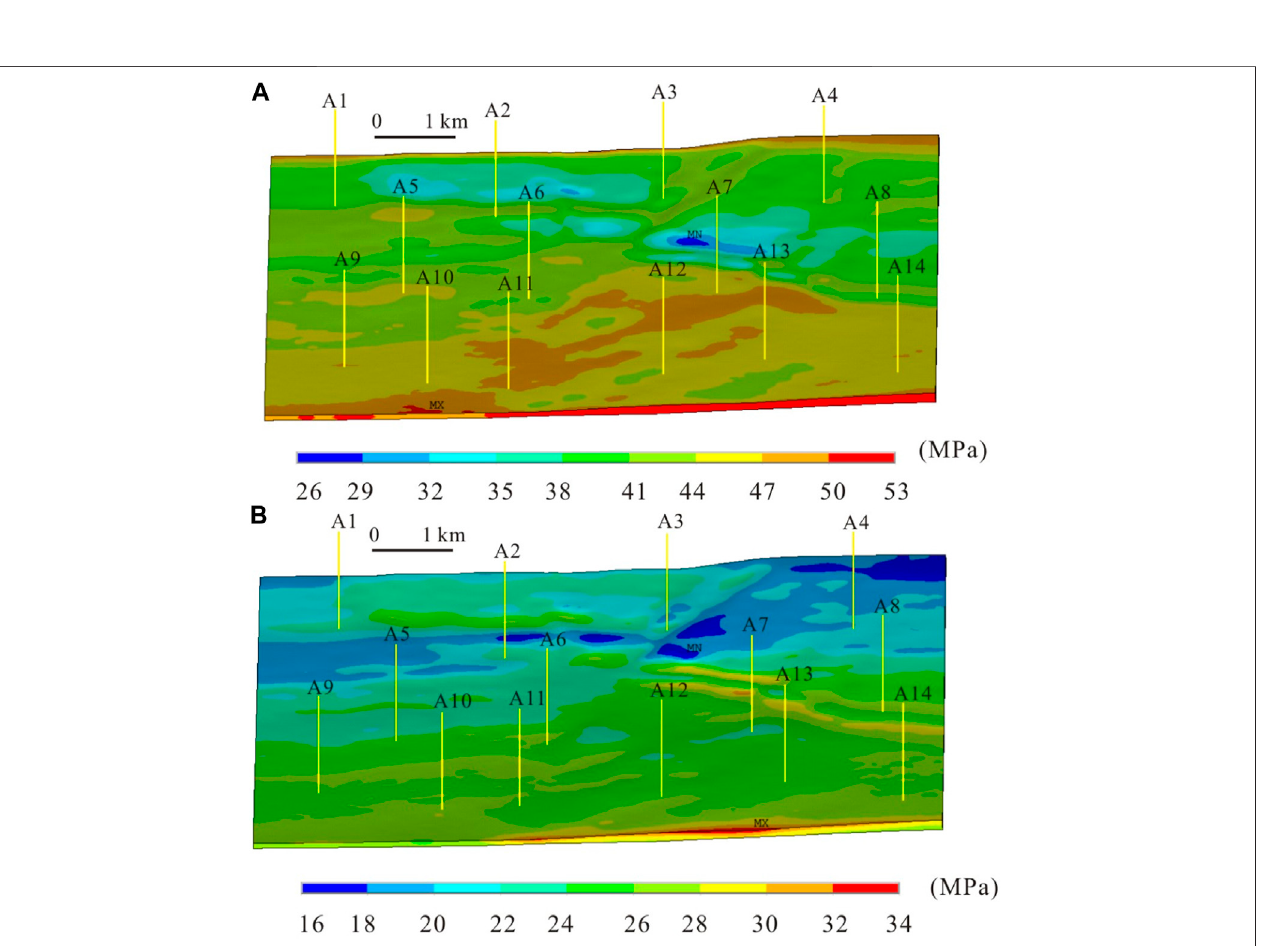
FIGURE 13 | Planar distribution of the horizontal principal stresses of the target layer. (A) Maximum horizontal principal stress; (B) Minimum horizontal principal stress.